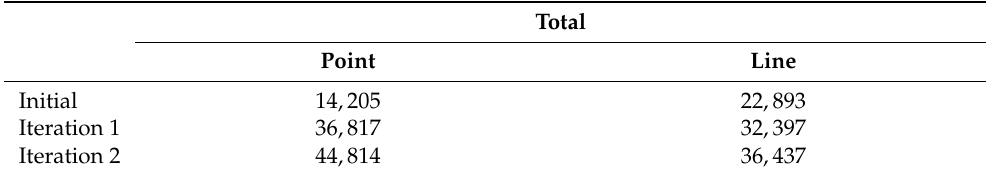
Table 1. Number of objects of interest in the entire dataset at different steps of the re-annotations